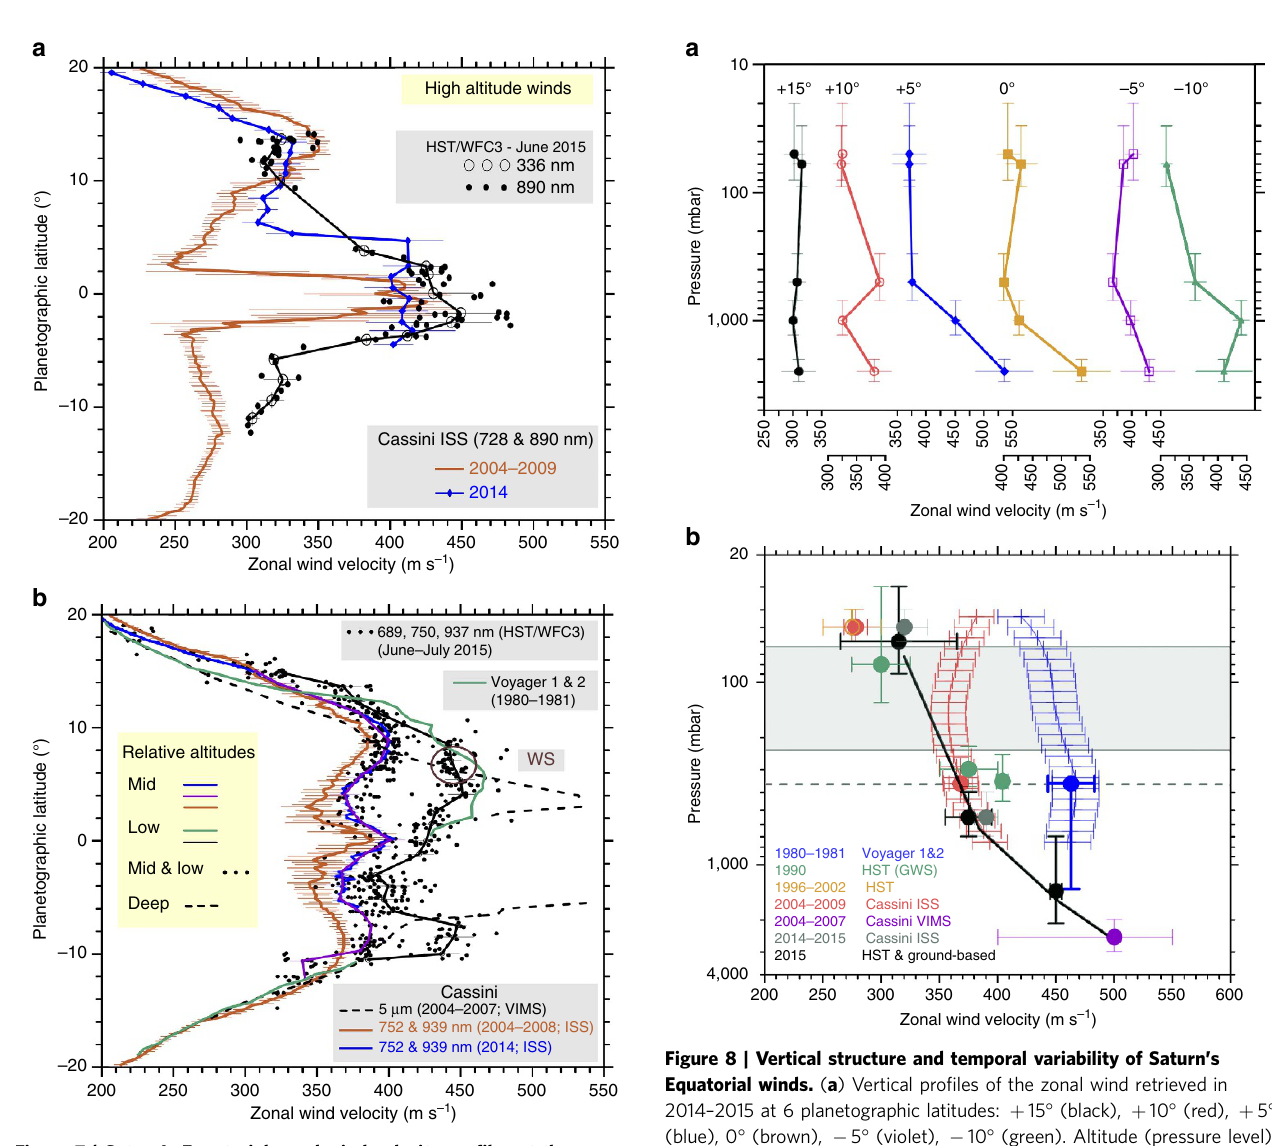
Figure 7 | Saturn’s Equatorial zonal wind velocity profiles at three altitude levels. ( a ) High-altitude winds for April to October 2014 (blue line) and June 2015 (black line and circles at 336nm and dots at 890nm), compared with an average from 2004 to 2009 (red line, ref. 13). ( b ) Mid level winds purple and blue lines) and low altitude winds (black line) in 2014-2015. The HST low speed points are binned and fitted by the purple line (mid level winds).The HST high-speed points are binned and fitted by the black line (low level winds). These profiles are compared with previous wind data from 1980–1981 (ref. 7) (green line), 2004–2007 (ref. 32) (dashed line) and 2004–2009 (ref. 13) (red line). The gaps are due to rings projection and shadow. The 2015 white spot related features are those within the magenta circle. Error bars in the profiles in ( a , b ) are defined from one s.d. from the mean velocity (ref. 13 and Methods section).